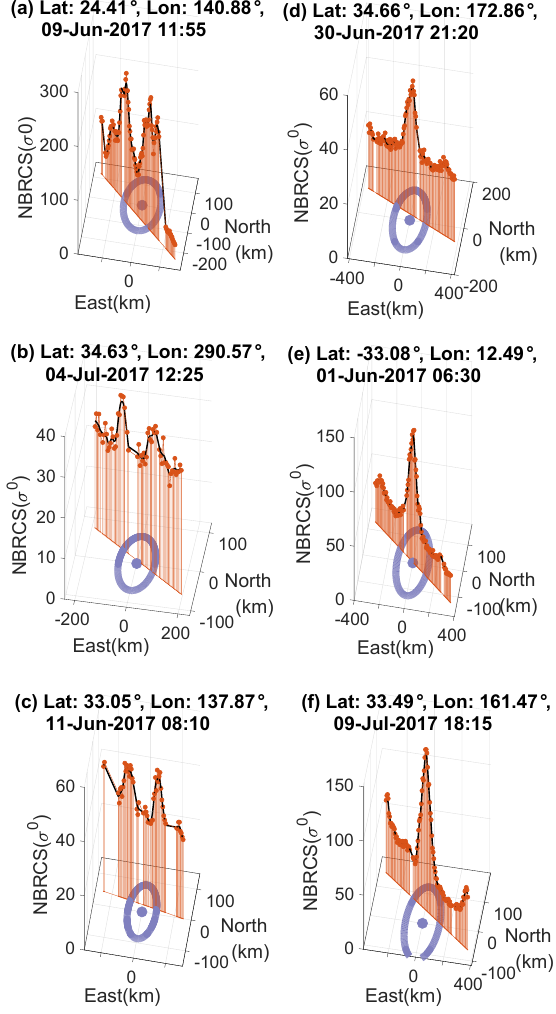
Figure 2. Exemplary cases of GNSS-Reflectometry σ 0 double-jump ( a – c ) and single-jump ( d – f ) behaviors observed in Cyclone GNSS (CYGNSS)